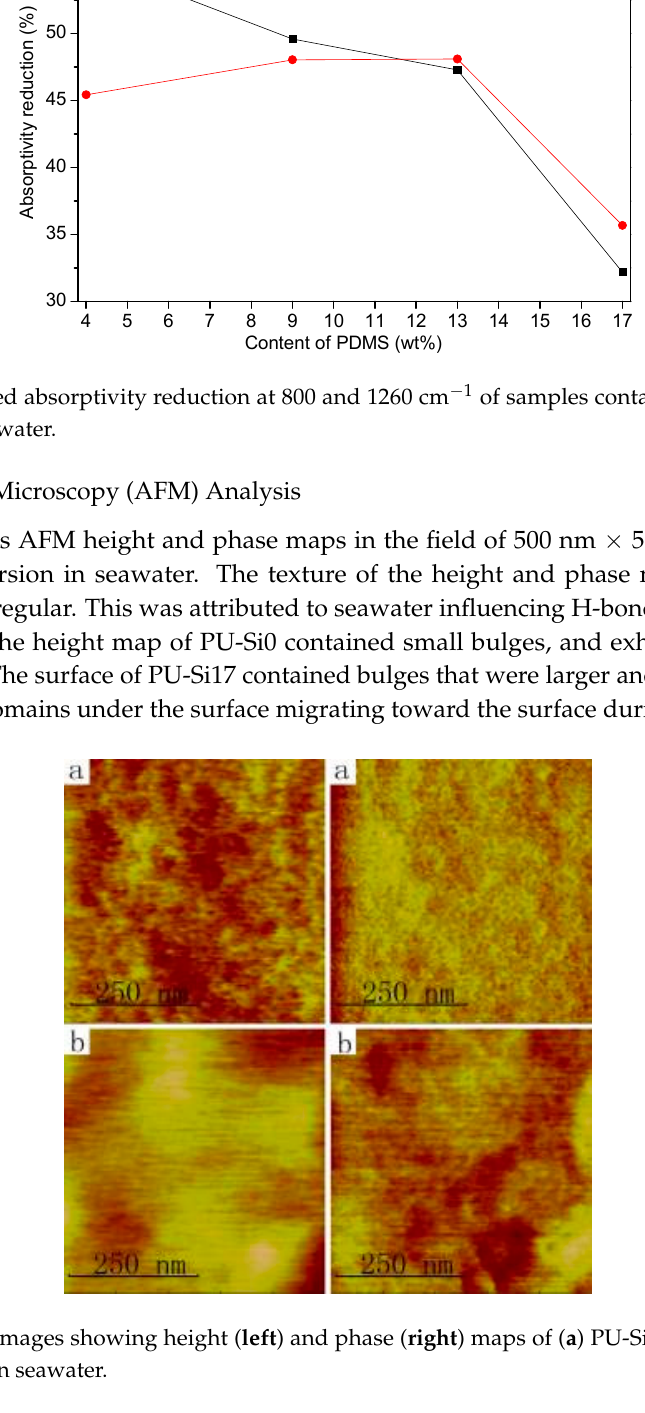
Figure 10. FTIR spectra of PU-Si4 before and after immersion in seawater.